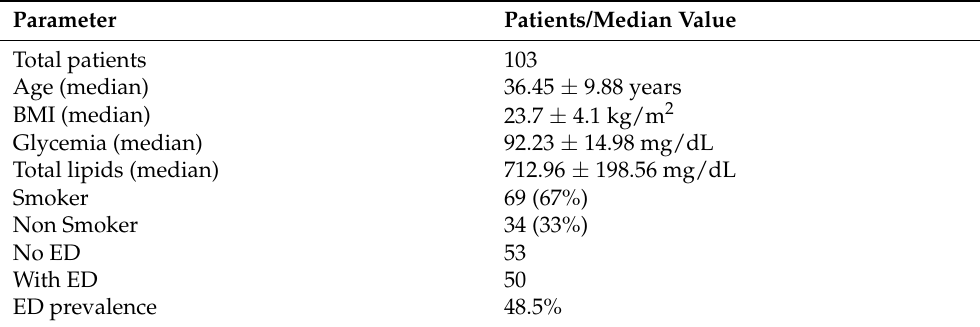
Table 2. Characteristics of the HIV-positive